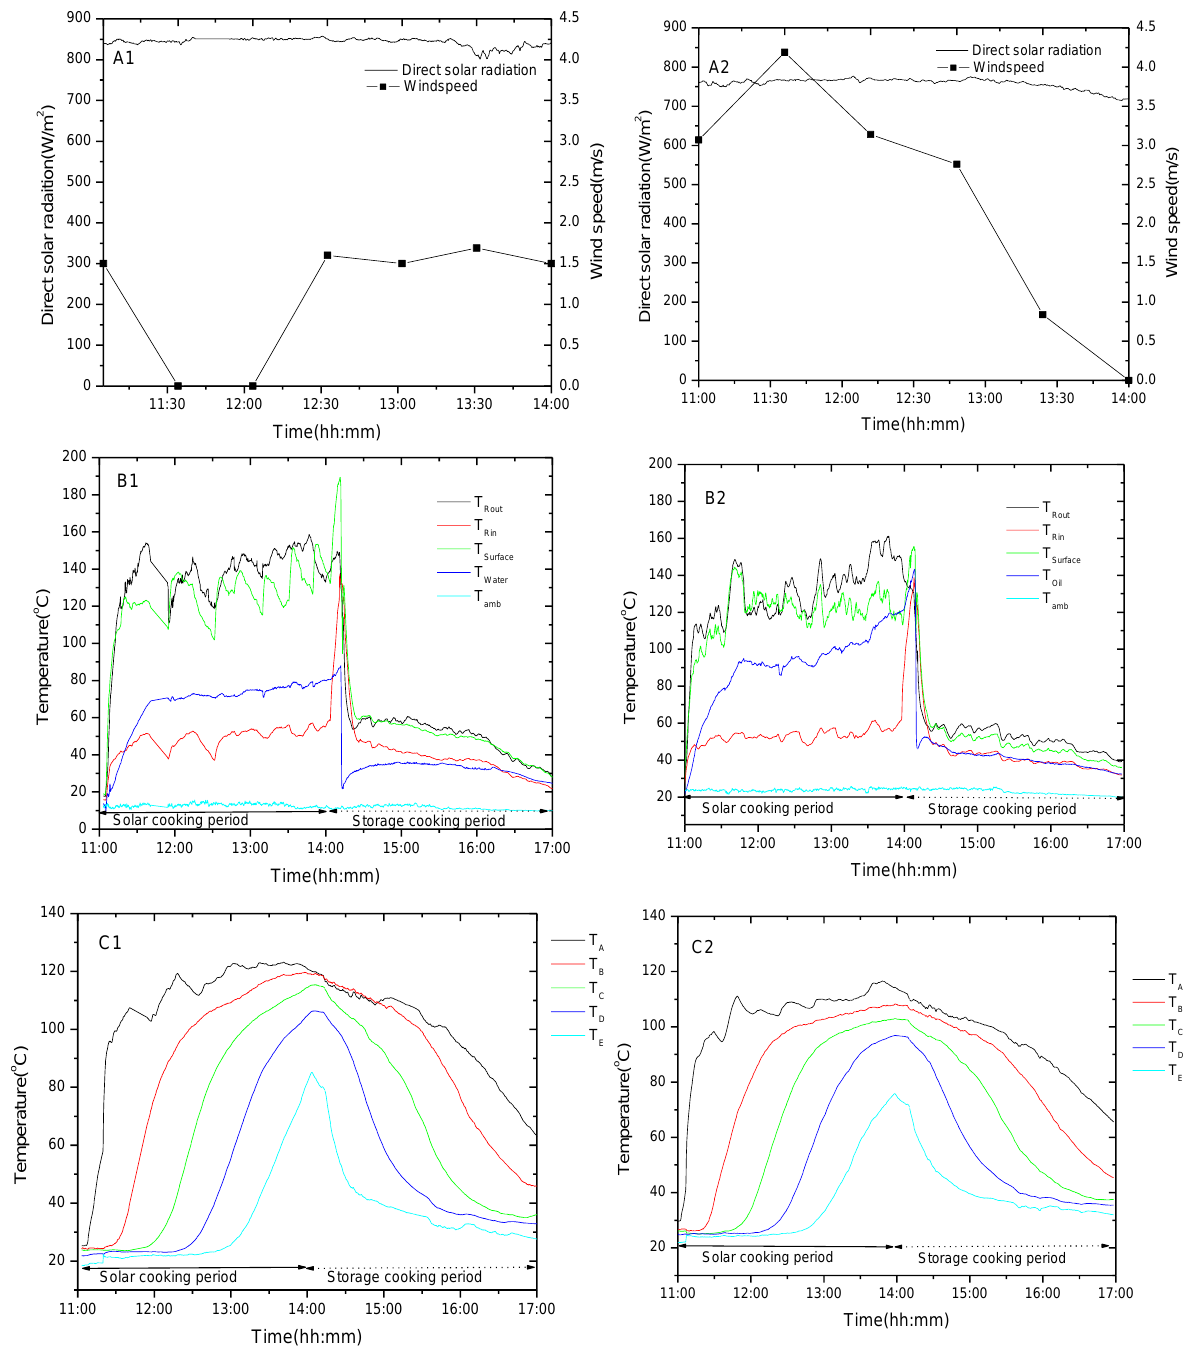
Figure 3. Experimental results of two test loads (water and sunflower oil) for a load of 0.5 kg utilizing a flow rate of 2.0 mL/s. ( A ) Direct solar radiation and wind speed ( A1 — water, A2 — sunflower oil), ( B ) the temperature profiles of the solar receiver ( B1 — water, B2 — sunflower oil), and ( C ) the temperature profiles of a storage tank ( C1 — water, C2 — sunflower oil). Experimental dates were 10 July 2021 and 13 July 2021 for water and oil tests, respectively.